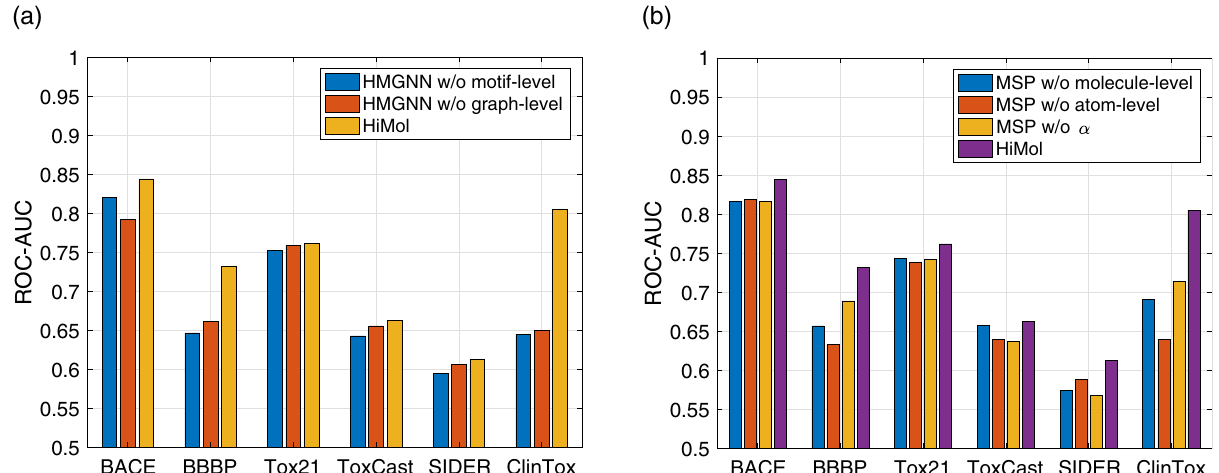
ClinTox0.5 BACE BBBP Tox21 ToxCast SIDER Fig. 5 Ablation effect of HiMol pre-training on classi fi cation benchmarks. a The performance of HMGNN with different ablations during pre-training. b The performance of MSP with different ablations during